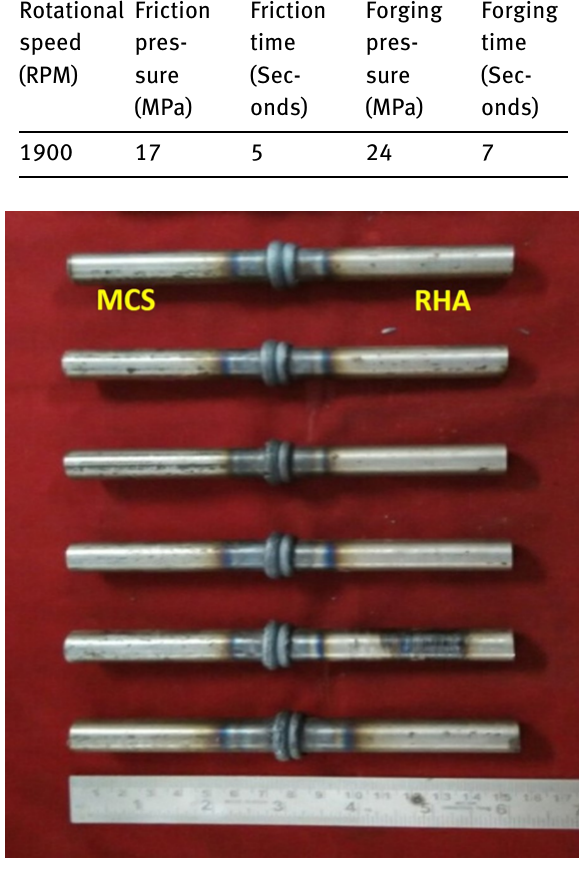
Figure 2: Photograph of dissimilar joint.